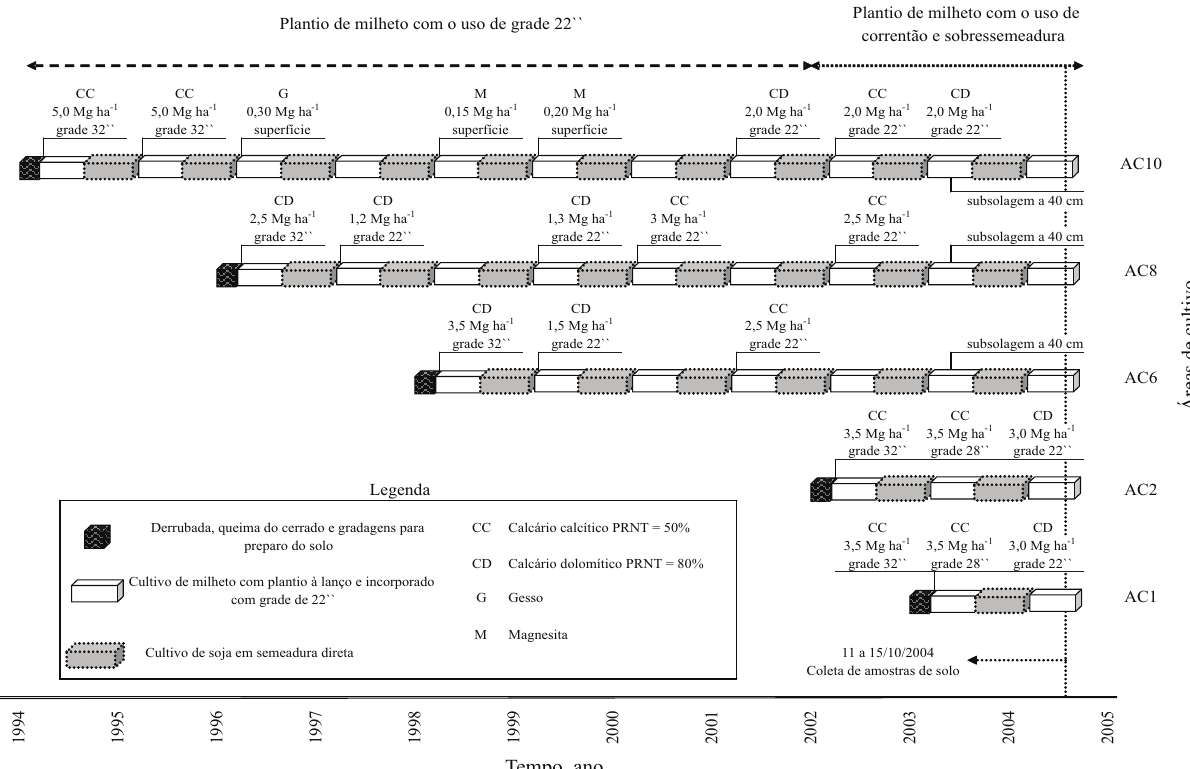
Figura 1. Esquema representativo do histórico das áreas de cultivo com um ano (AC1), dois anos (AC2), seis anos (AC6), oito anos (AC8) e 10 anos (AC10), em Alto Garças,